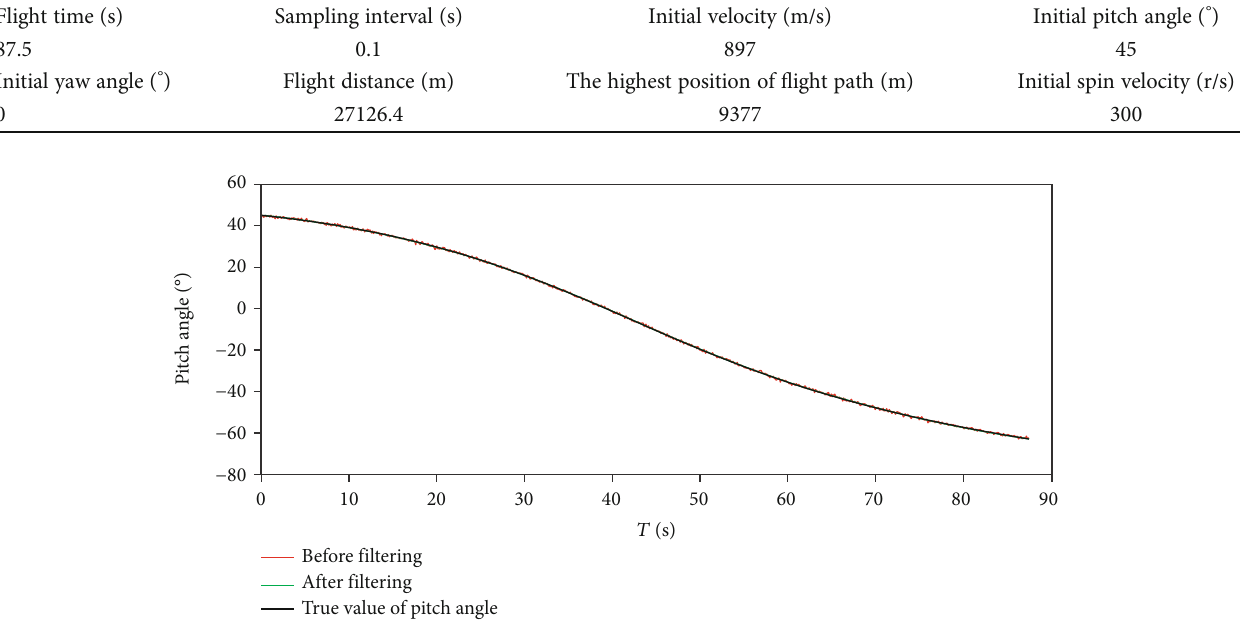
Figure 4: Pitch angle curve before and after fi